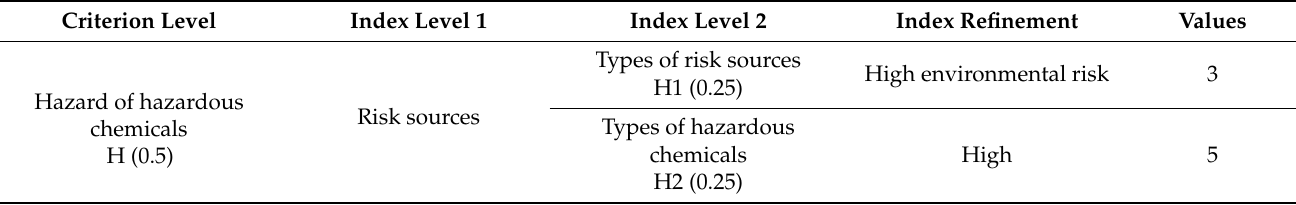
Table 6. Risk-assessment level of XX company in